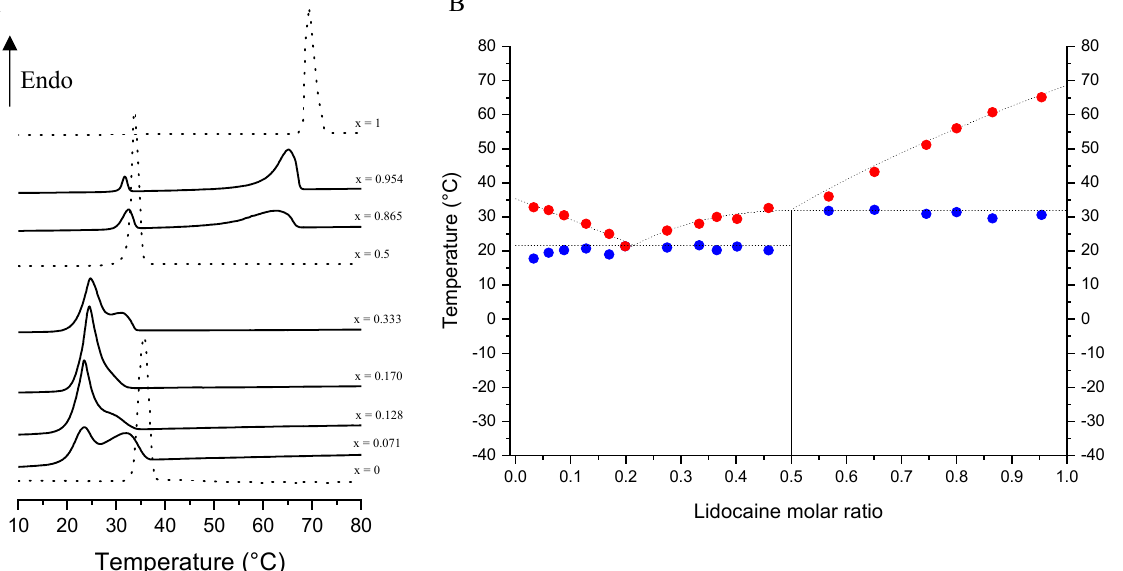
Figure 5. ( A ) Differential scanning calorimetry thermograms obtained for pure compounds, namely DL -menthol ( ··· , bottom curve), Lido: DL M 1:1 stoichiometric compound ( ··· , middle curve), and lidocaine ( ··· , top curve), for DL -menthol/Lido: DL M mixtures (–, the 4 bottom curves), and for Lido: DL M/lidocaine mixtures (–, the 2 top curves). The lidocaine molar ratio, x, is indicated for each sample. Endothermic transformations give signals which point up. ( B ) Related stable Lido: DL M phase diagram. The experimental data (full circles. The solidus and liquidus points are represented in blue and red, respectively) and the ideal behavior (dotted line) determined with the Schröder-van Laar relation are shown.